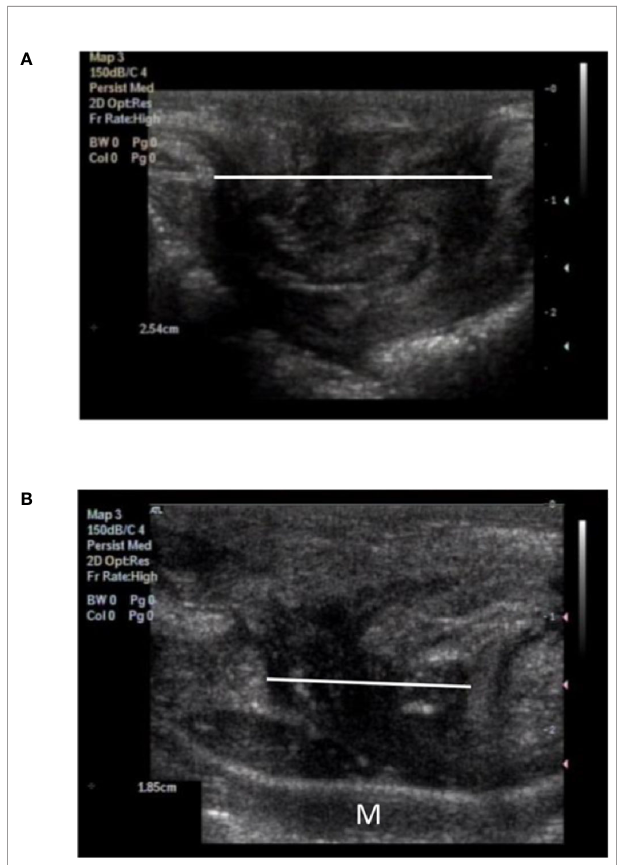
FIGURE 2 | Appearance of the congenital hernia using ultrasonographic imaging before and after mesh implantation surgery. (A) Ultrasonographic evaluation before surgical mesh implantation (maximal diameter of the hernia 2.54 cm). (B) Ultrasonographic fi ndings 1 month after mesh implantation surgery. A decrease in the diameter of the hernia can be observed (maximal diameter of the hernia 1.85 cm). Implanted mesh (M) appears as a linear echogenic